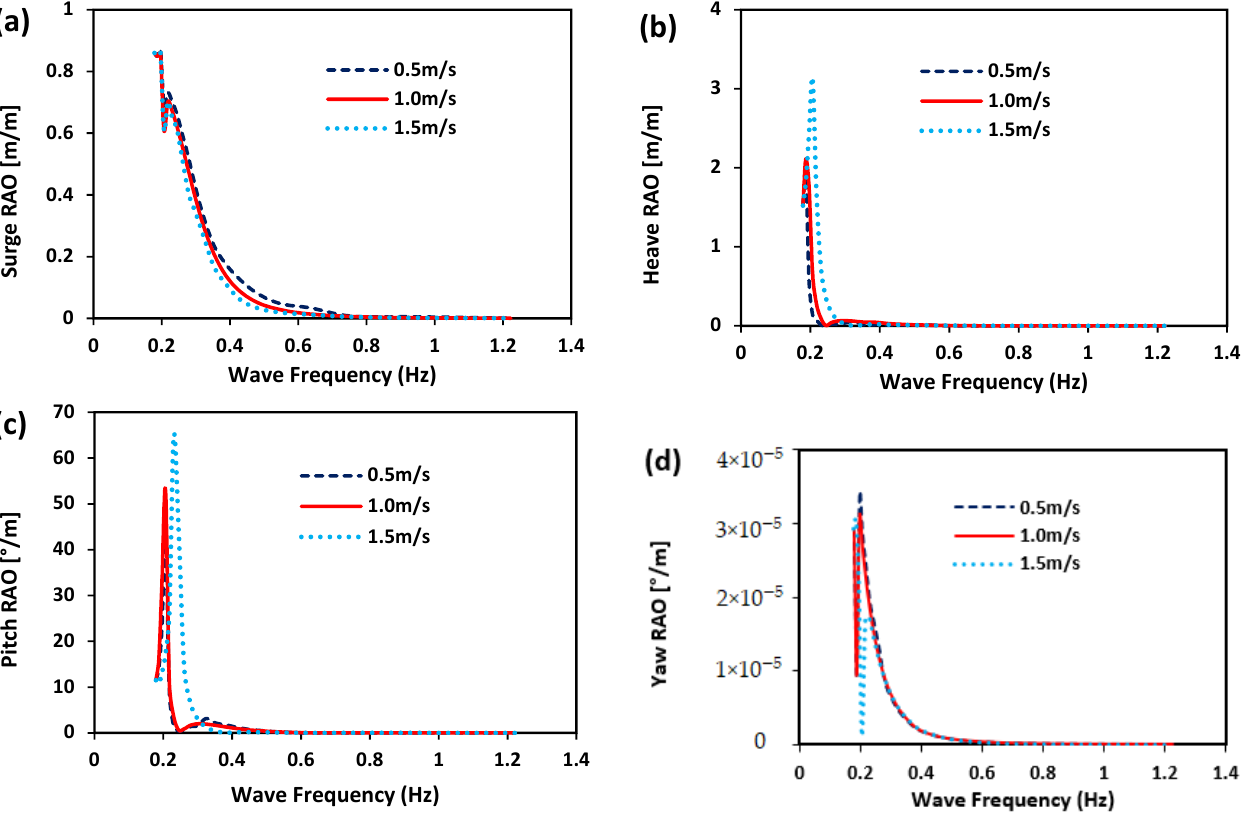
Figure 26. Influence of the current velocity on the motion RAOs for the CALM buoy, showing (a) surge, (b) heave, (c) pitch and (d) yaw.